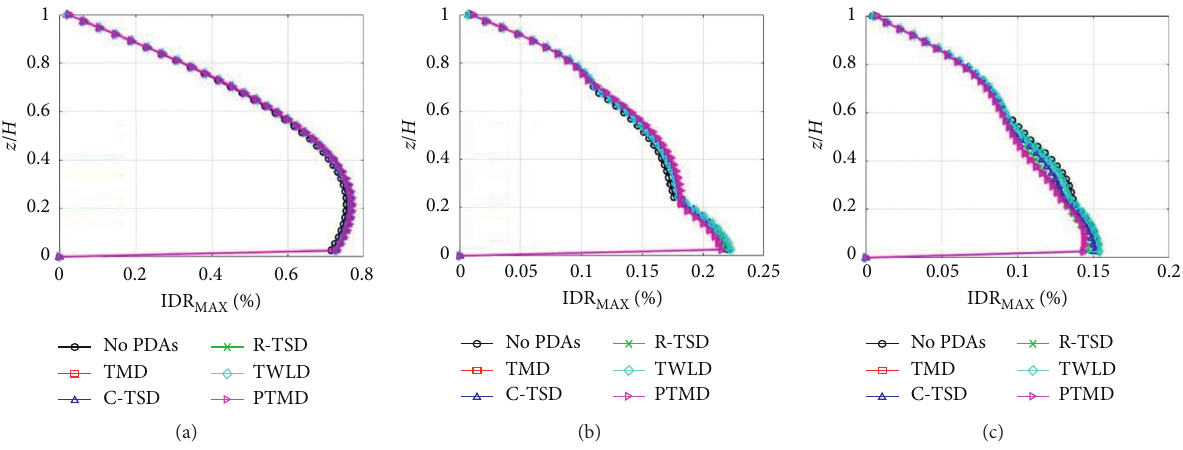
Figure 13: Seismic peak interstory drift ratios of the building: xz plane. (a) CDAF. (b) SXVI. (c)